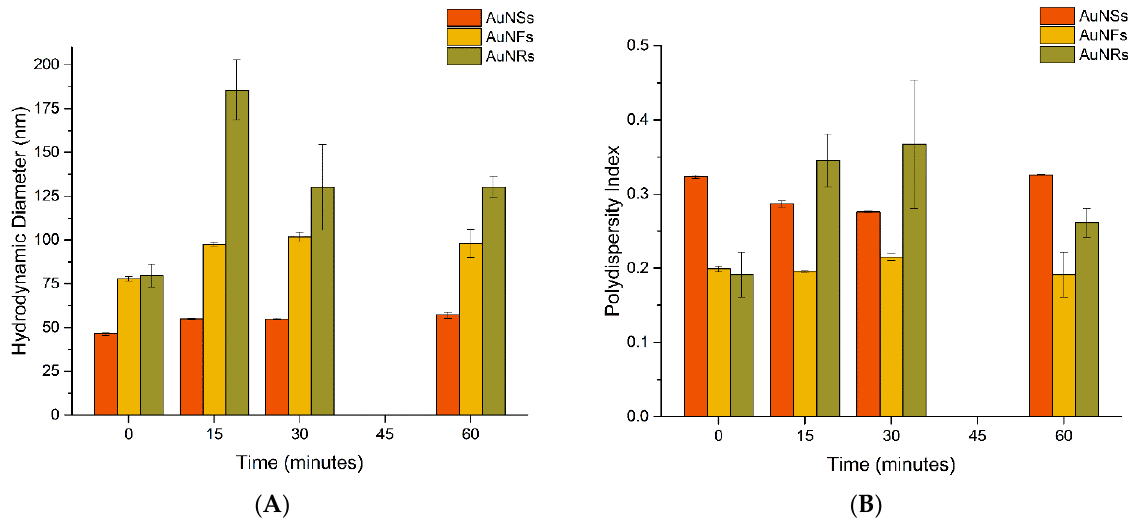
Figure 3. ( A ) Hydrodynamic diameter and ( B ) polydispersity index of AuNPs before and after incubation with urine samples.